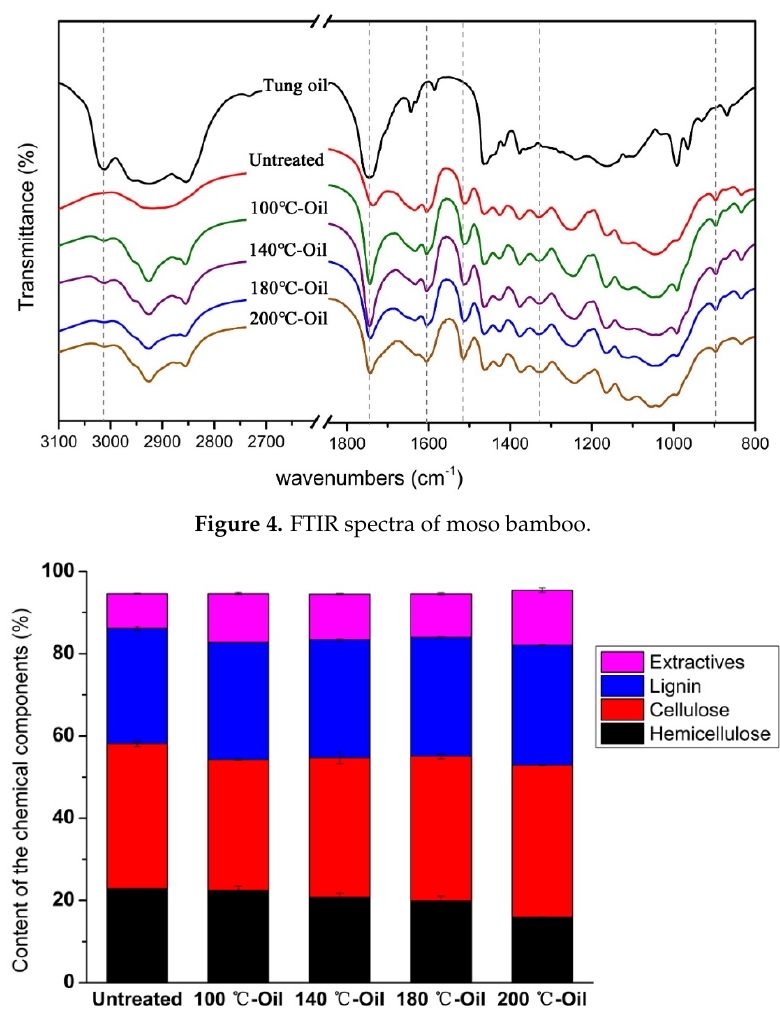
Figure 5. Chemical compositions of untreated and tung oil treated bamboo samples.